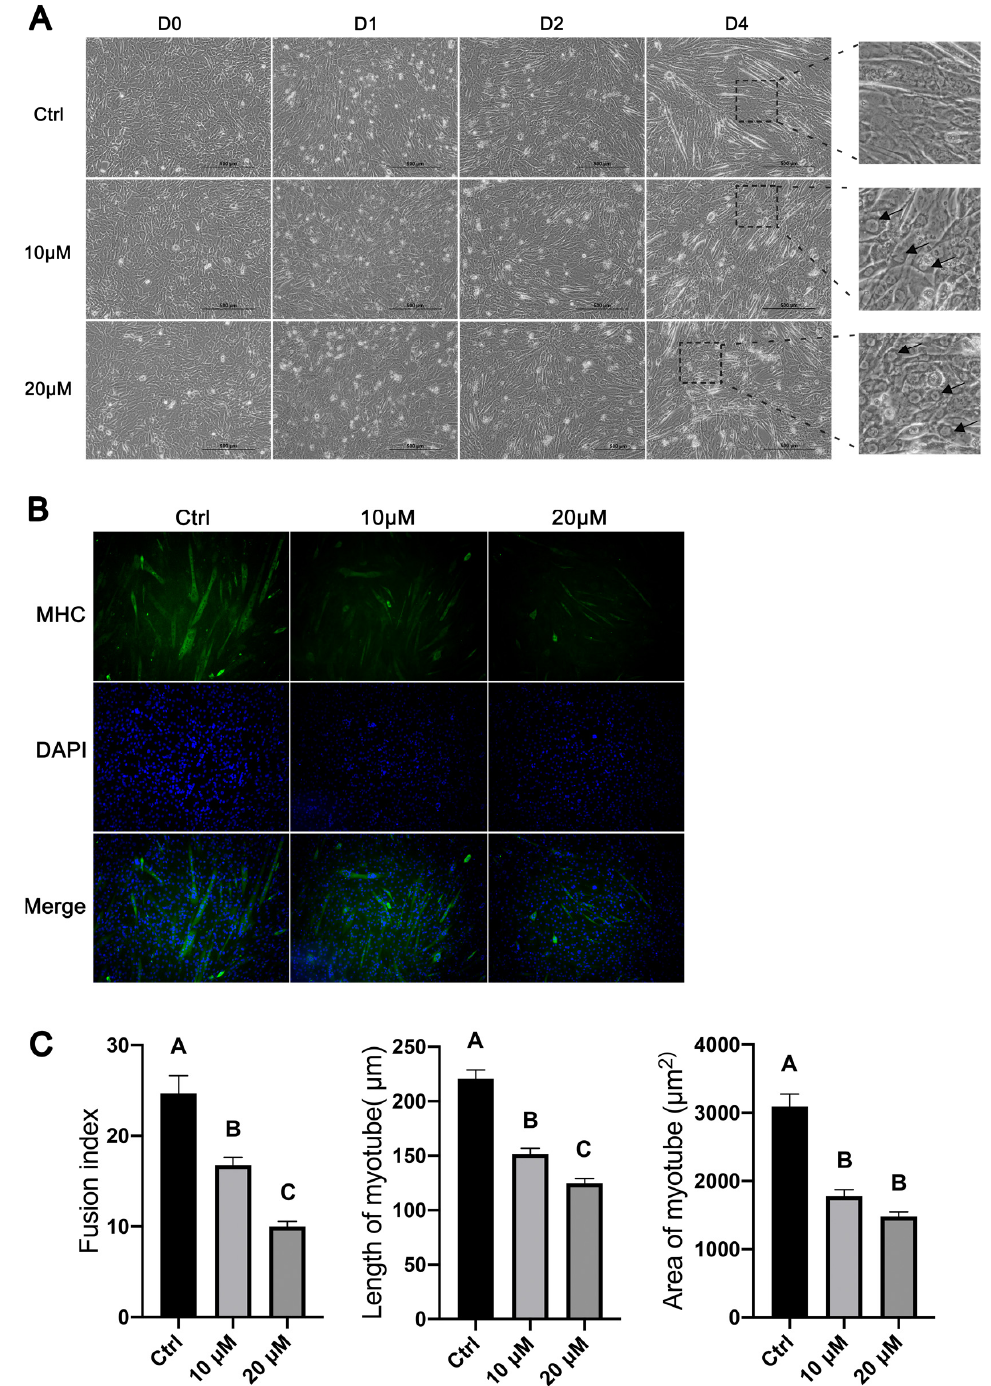
Figure 5. Effects of inhibiting autophagy with chloroquine on the morphological changes in C2C12 cells during myoblast differentiation. C2C12 cells were cultured in differentiation medium in the presence of 10 or 20 μ M chloroquine. Control (ctrl) C2C12 cells were cultured in differentiation medium in the absence of chloroquine. ( A ) Representative micrographs of C2C12 cells on days (D) 0, 1, 2, and 4 of differentiation. Arrows point to “dark rings” around the nuclei in CQ-treated cells. ( B ) Representative micrographs of C2C12 cells on day 4 of differentiation. Cells were stained with myosin heavy-chain (MHC) antibody (green) and DAPI (blue). ( C ) Quantification of fusion index and length and area of myotubes. Bars not sharing the same letter labels are different ( p < 0.05, n = 8), based on Tukey’s